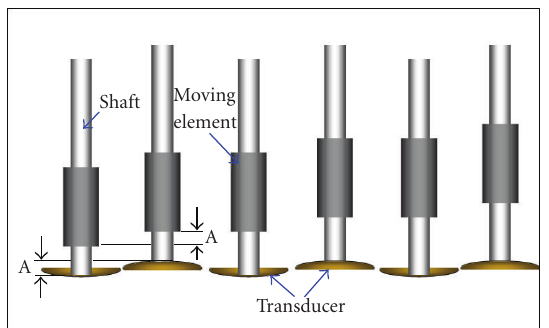
Figure 1: Operation principle of an